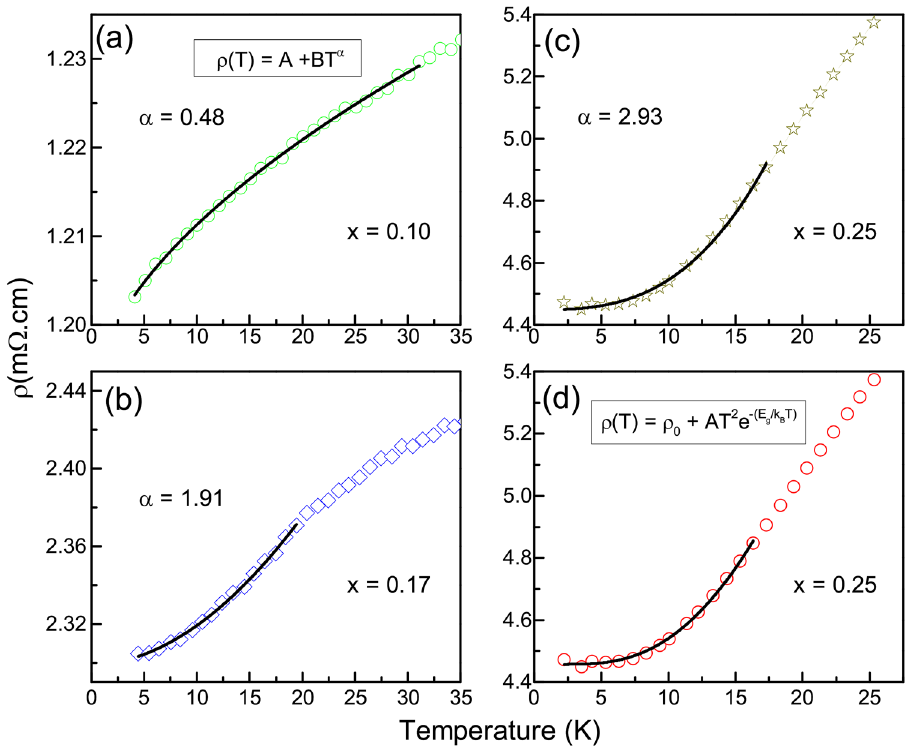
Figure 10. Power law fitted to the low temperature ρ (T) plots of Cr-substituted compositions. Line represents the fit to the experimental data represented by